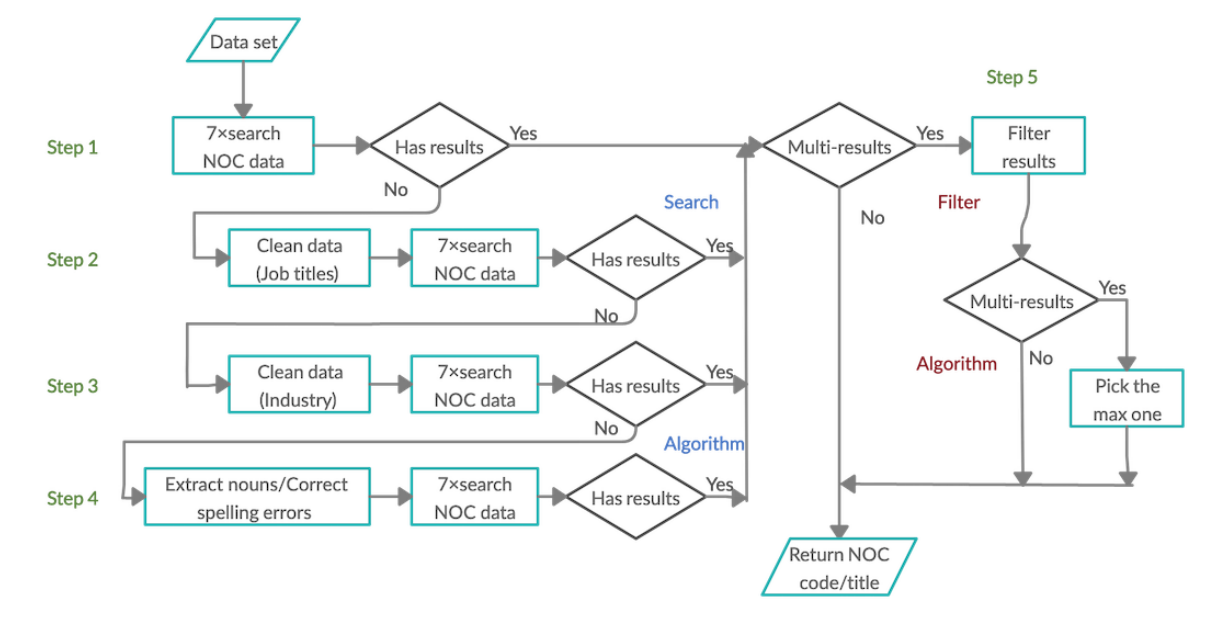
Figure 1. ACA-NOC algorithm. NOC: National Occupational